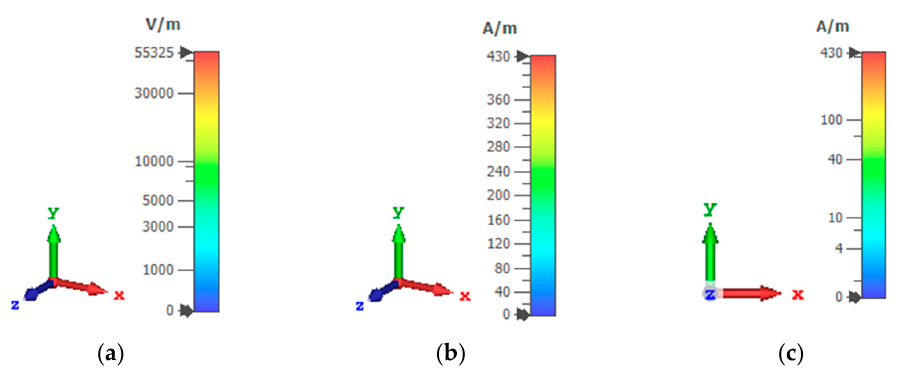
Figure 11. ( a ) Electric field, ( b ) magnetic field, and ( c ) surface current density of Roger4450B. The E-field, H-field, and surface current results show that the electric field concen- tration is proportional to the surface current density and that magnetic field lags